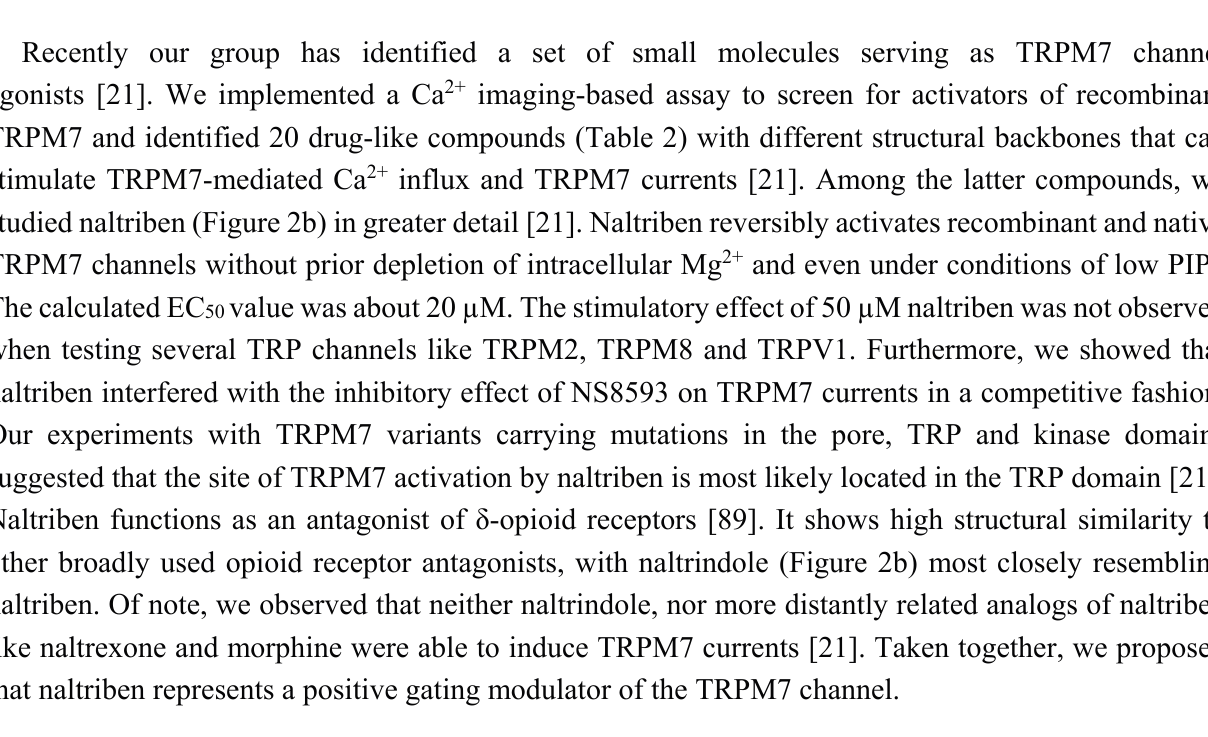
Table 2. Organic compounds activating TRPM7 channel